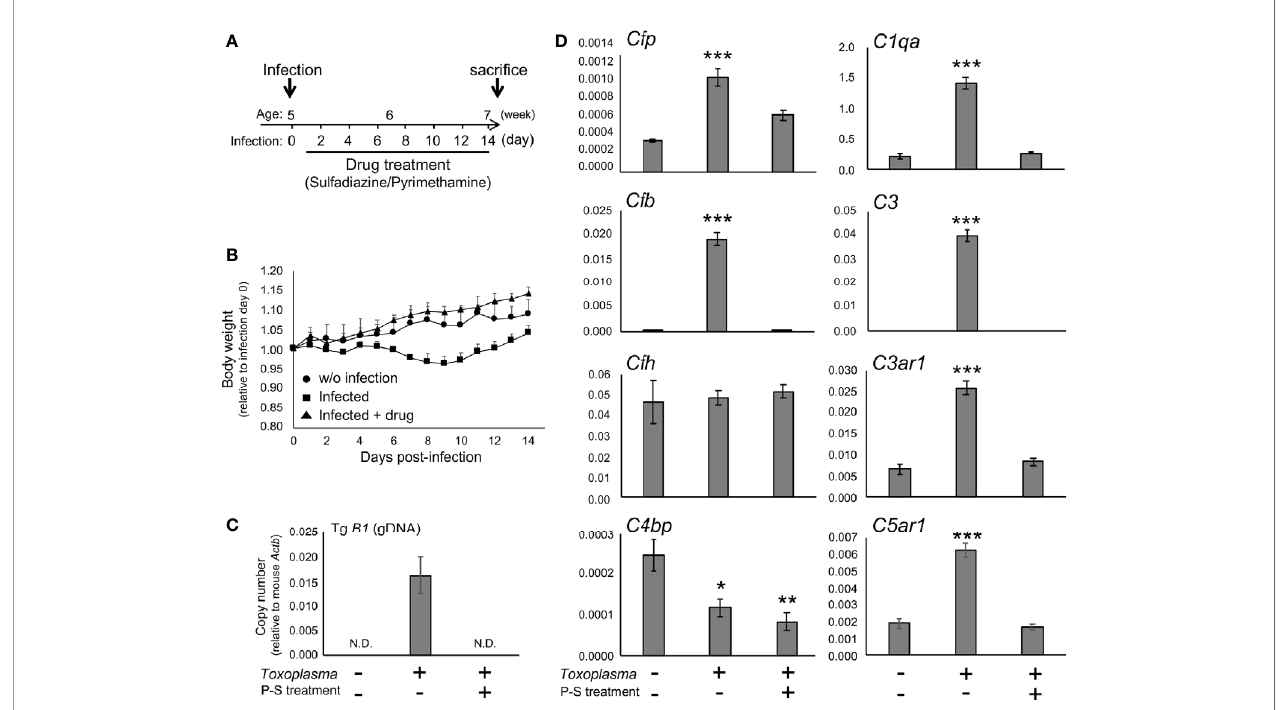
FIGURE 1 | Toxoplasma infection induced the expression of alternative complement components and anaphylatoxin receptors in the brain. (A) Experimental scheme. C57BL/6J mice were divided into three groups: without infection (n=3), T. gondii infection (n=6), and T. gondii infection plus drug treatment (Sulfadiazine and pyrimethamine) (n=3). Infection groups received oral inoculation of T. gondii (Fukaya, three cysts) on day 0 at the age of 5 weeks, and one group received drug treatment daily from day 1 for 2 weeks until sacri fi ce. (B) Body weight change after Toxoplasma inoculation. Data are presented as means ± SEM values relative to body weight at day 0. Filled circle: without infection; fi lled square: infection; fi lled triangle: infected with drug treatment. (C) T. gondii gDNA levels were quanti fi ed by qPCR. Values were normalized to mouse b -actin ( Actb ). Data are presented as Means ± SEM. (D) mRNA levels for complement components (properdin: Cfp , factor B: Cfb , factor H: Cfh , C4b-binding protein: C4bp , C1q: C1qa , C3: C3 , C3aR: C3ar1 , and C5aR1: C5ar1 ) in the cortex. Data are presented as means ± SEM. * p < 0.05, ** p < 0.01 *** p < 0.001 (Dunnett ’ s test vs. control). The representative outcome of two independent experiments are